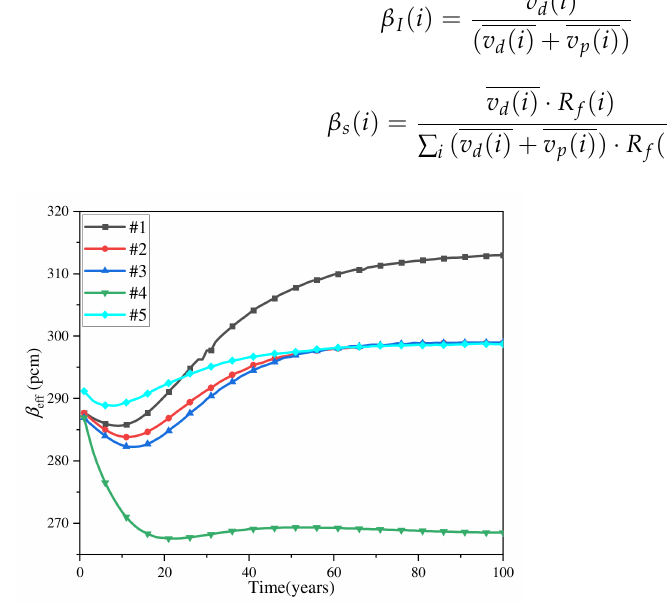
Figure 14. Evolution of β eff during the